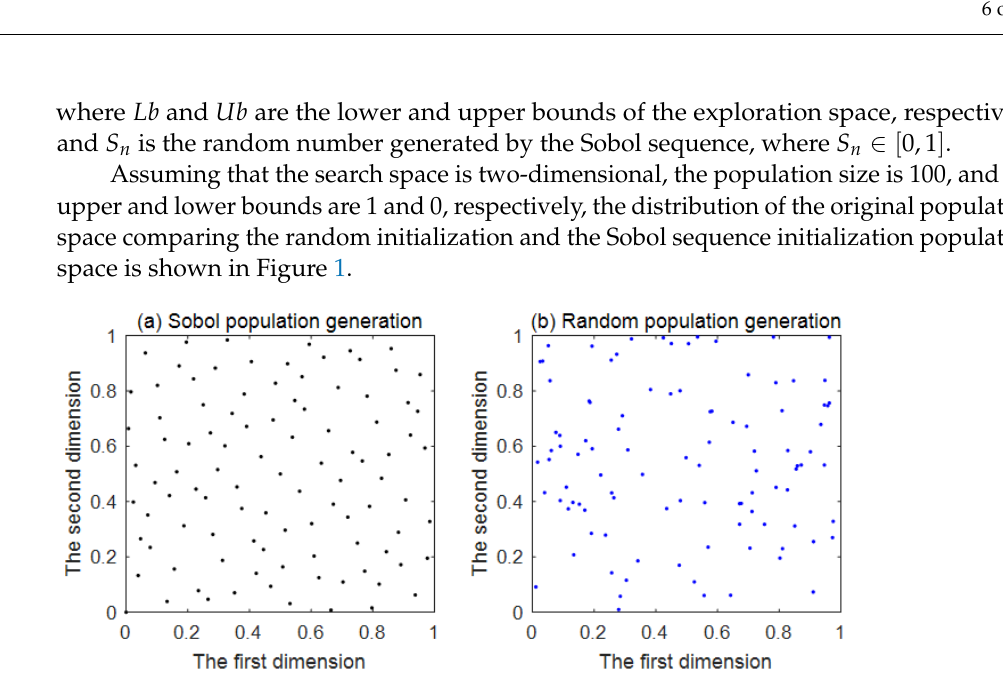
Figure 1. Comparison of Sobol population generation and random population